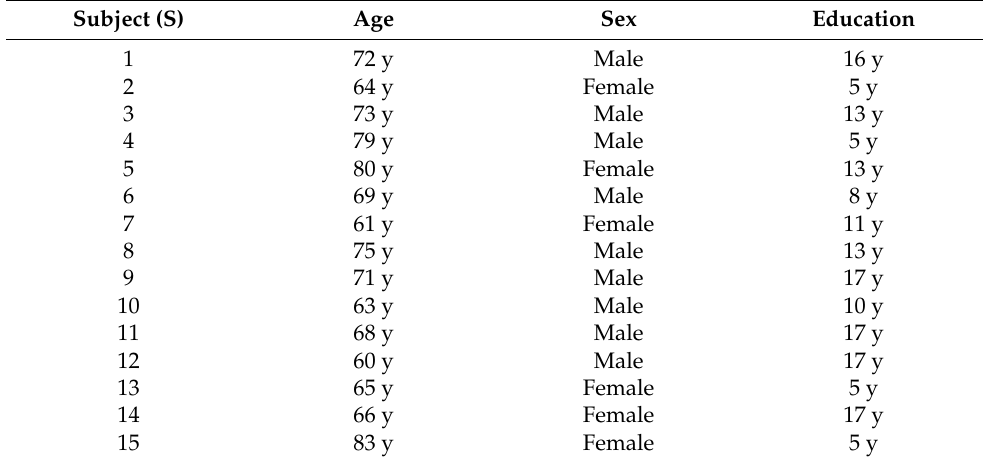
Table 1. Demographic characteristics of included participants.